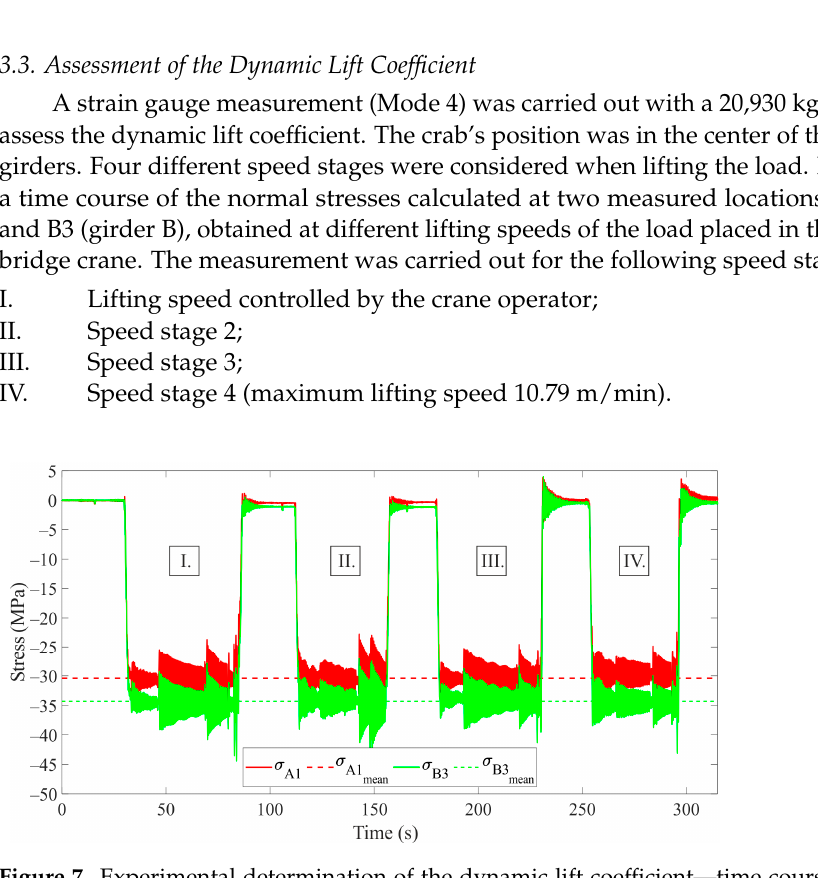
Figure 7. Experimental determination of the dynamic lift coefficient—time courses of calculated normal stresses and visualization of their mean values. The dynamic lift coefficient determined from the courses shown in Figure 7 ranges from 1.13 to 1.27. According to STN 270103 standard [23], the coefficient δ h = 1.37, which is higher than the measured value, is considered for lifting class